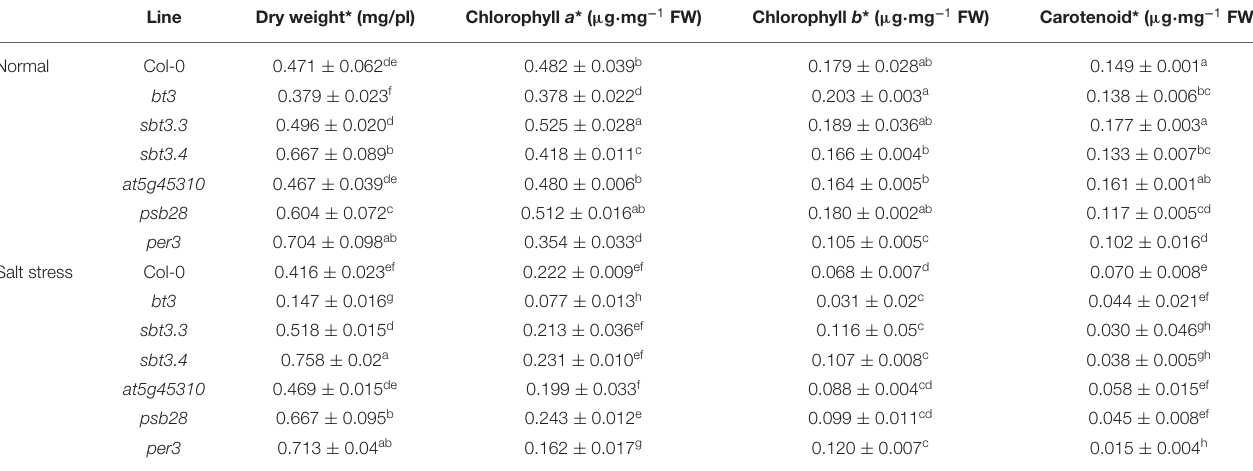
TABLE 5 | Dry weight per plant, chlorophyll a , chlorophyll b and carotenoid contents of 14 day-old Col-0 wild type, bt3 , sbt3.3 , sbt3.4 , at5g45310 , psb28 , and per3 mutants grown in MS medium or MS medium supplemented with 100mM NaCl for 7 days.